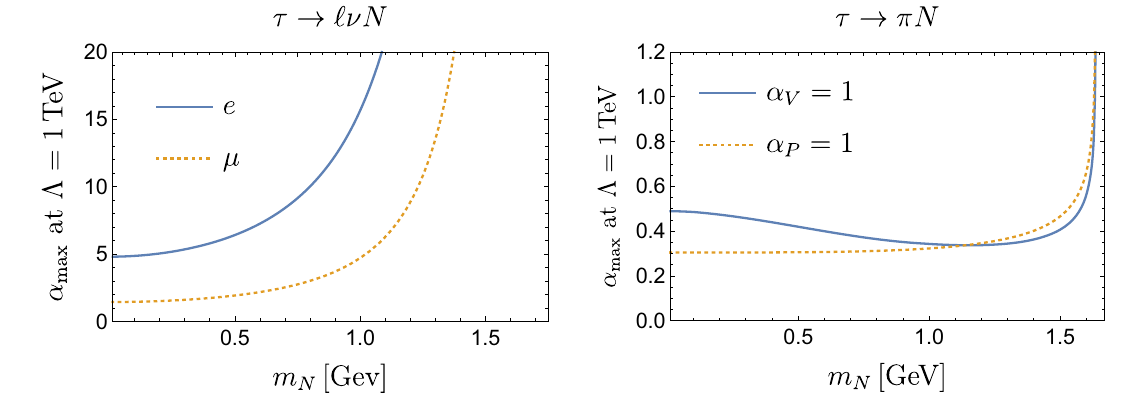
Fig. 1 RH neutrino mass dependence of the one-parameter fit limits from τ decays. Left: limits on α LNLe from the process τ → (cid:4)ν N . The mass on the charged leptons has been neglected. Right: limits on α V = α qq